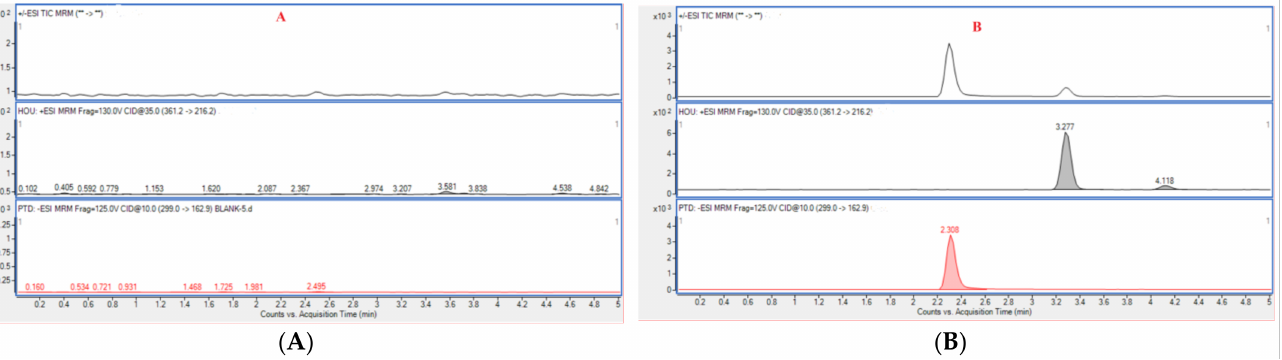
Table 2. Influence of different HCl concentrations on the results of derivatization. Catalyst Concentration (%) HCl